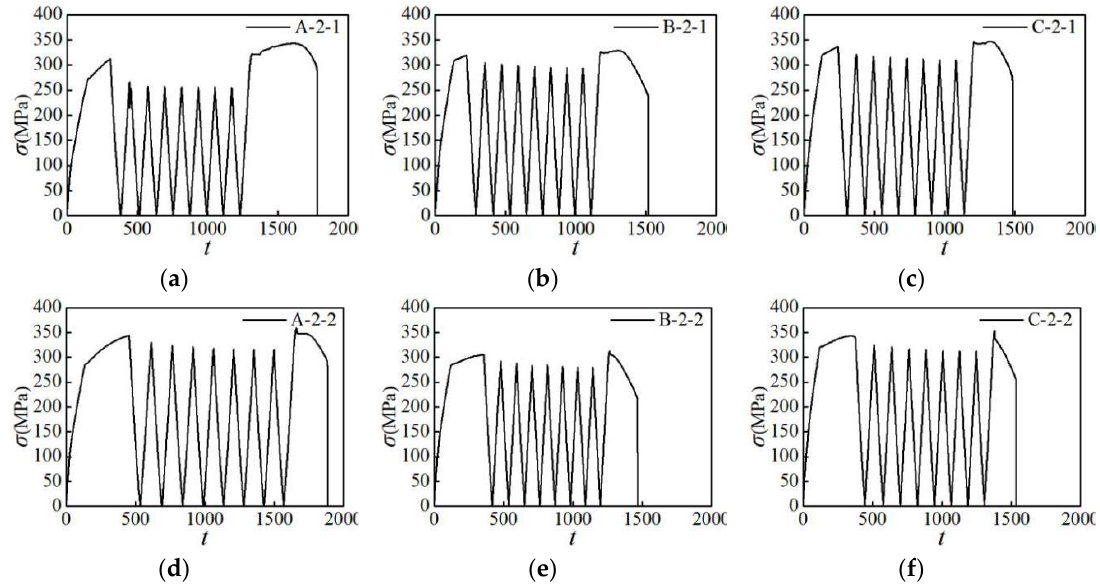
Figure 7. Stress-time curves of specimens (Units: s): ( a ) A-2-1 specimen; ( b ) B-2-1 specimen; ( c ) C-2-1 specimen; ( d ) A-2-2 specimen; ( e ) B-2-2 specimen; ( f ) C-2-2 specimen.